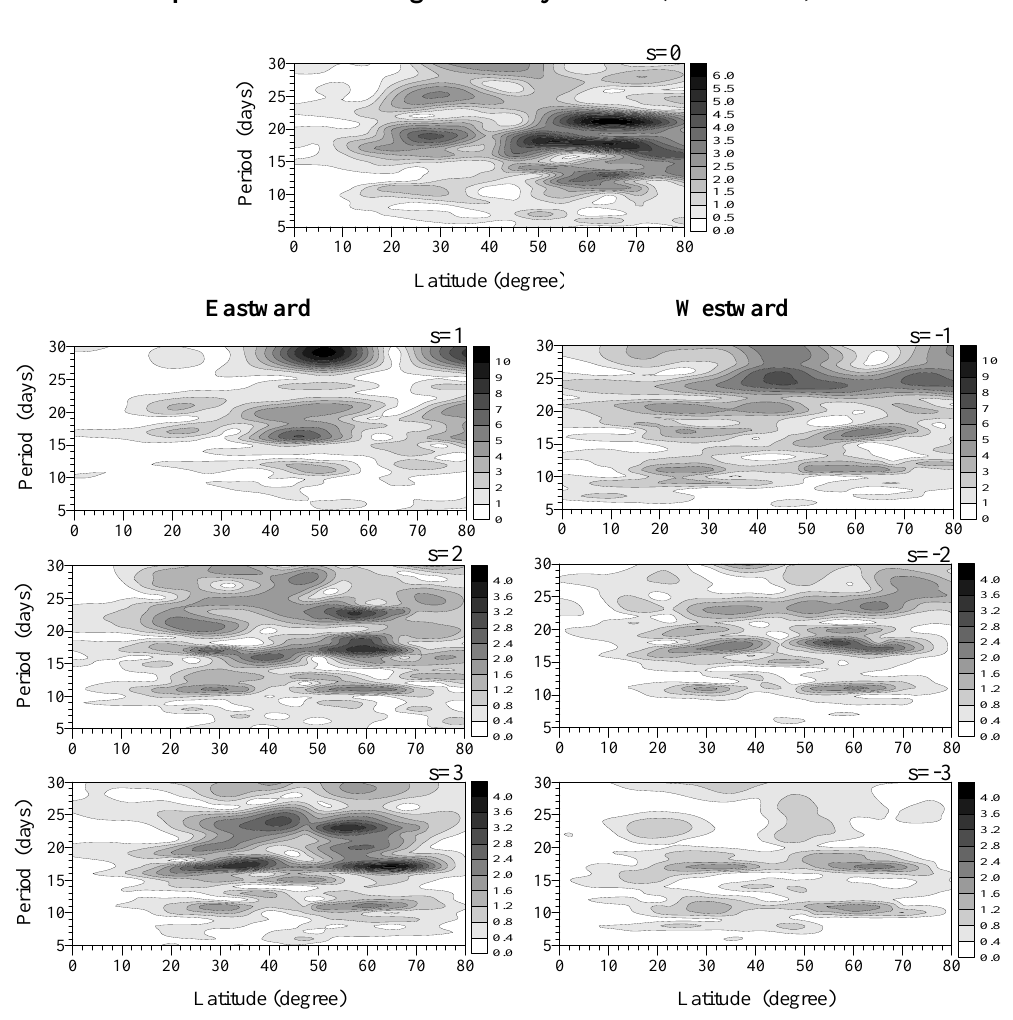
Fig. 2. Latitudinal amplitude spectra of the zonally symmetric ( s =0) waves (upper plot), eastward (left column of plots) and westward (right column of plots) travelling waves with zonal wavenumber up to 3 calculated from the zonal wind data at 1hPa pressure level for the